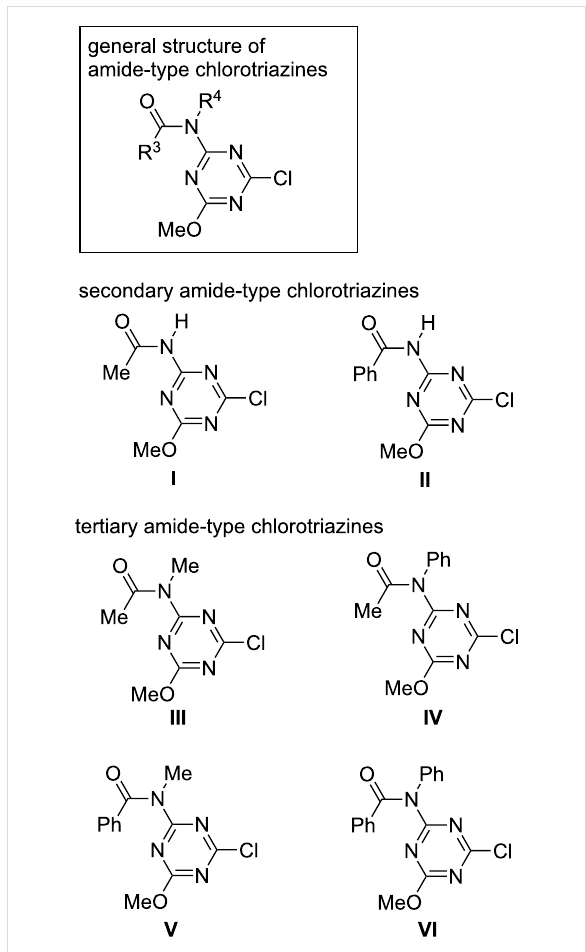
Figure 1: Structures of amido-substituted